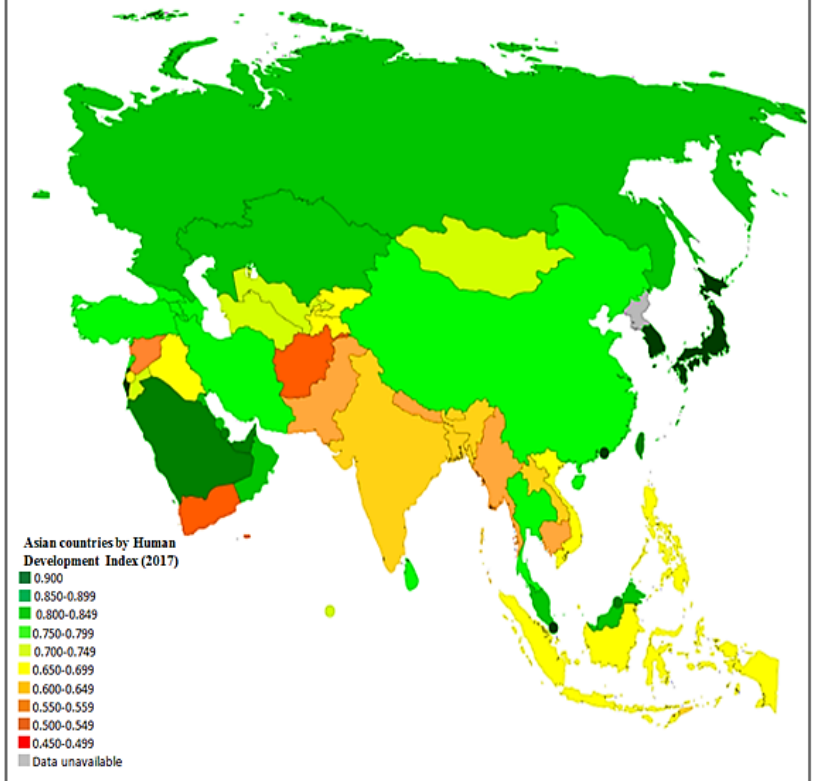
Figure 3: Average Human Development Index in Asian Countries Source: World Bank